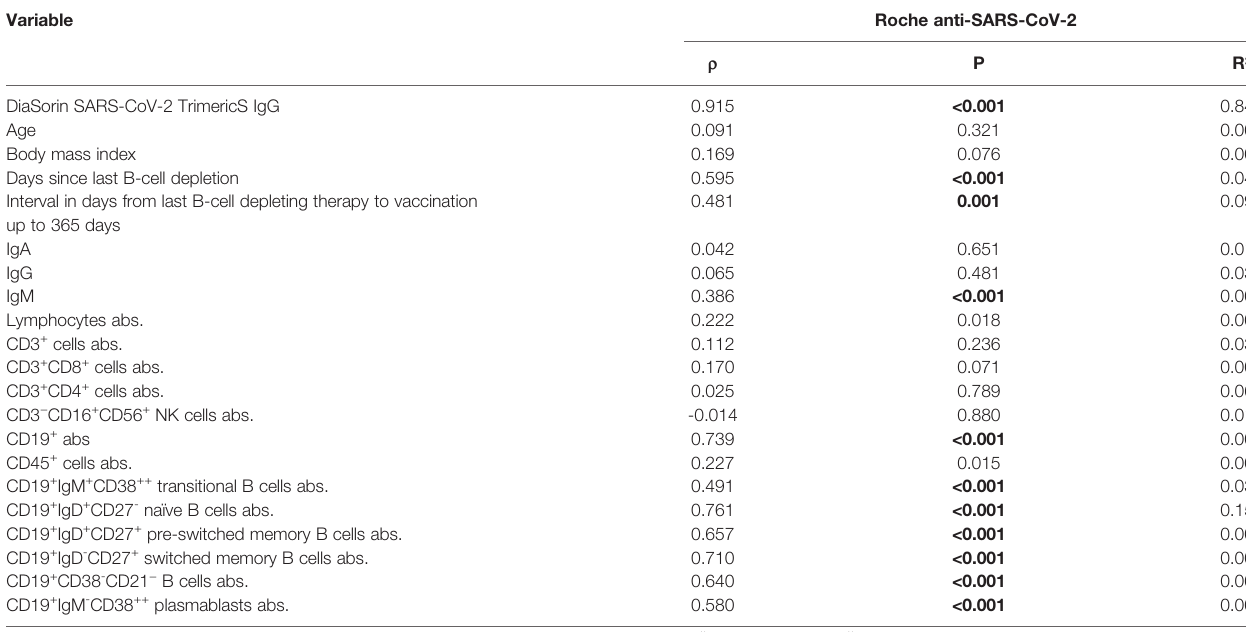
TABLE 3 | Correlations of SARS-CoV-2 antibody response with variables in the immunocompromised study population. Variable Roche anti-SARS-CoV-2